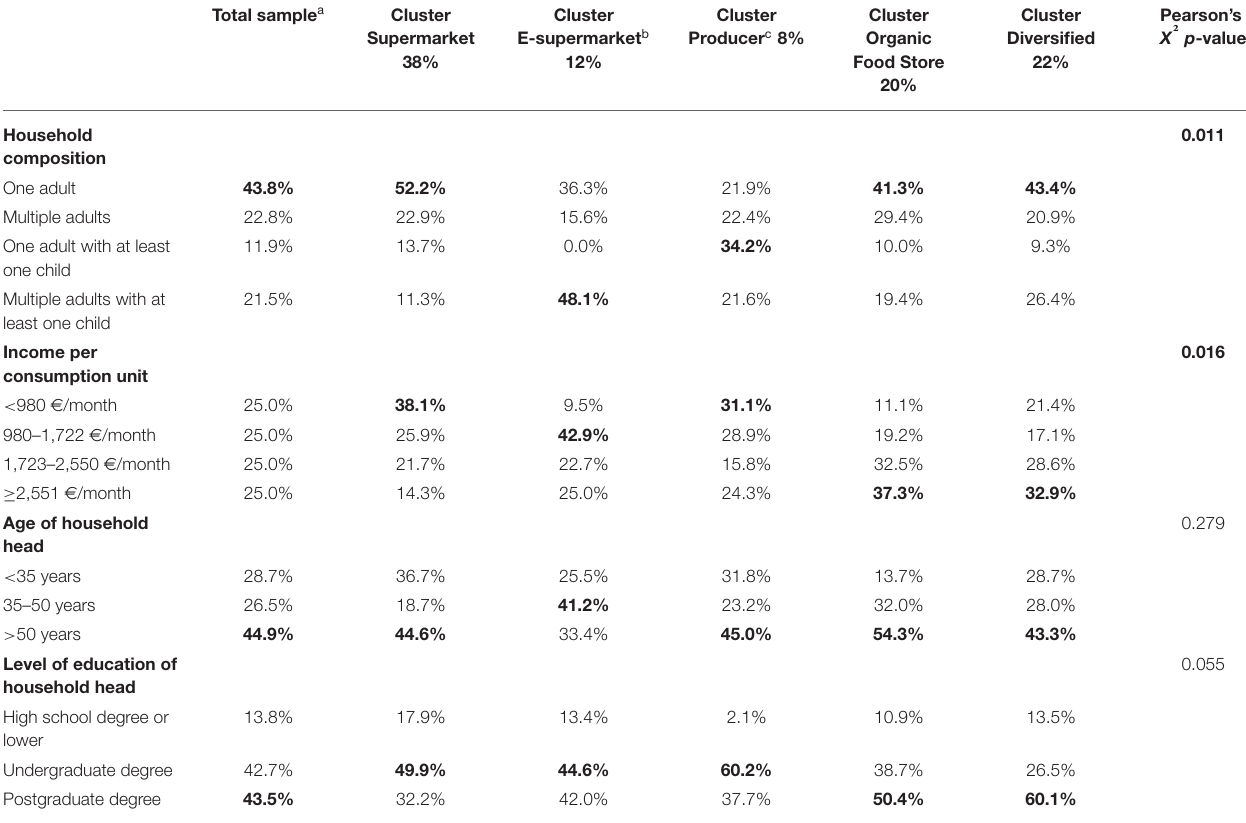
TABLE 1 | Households’ socioeconomic and demographic